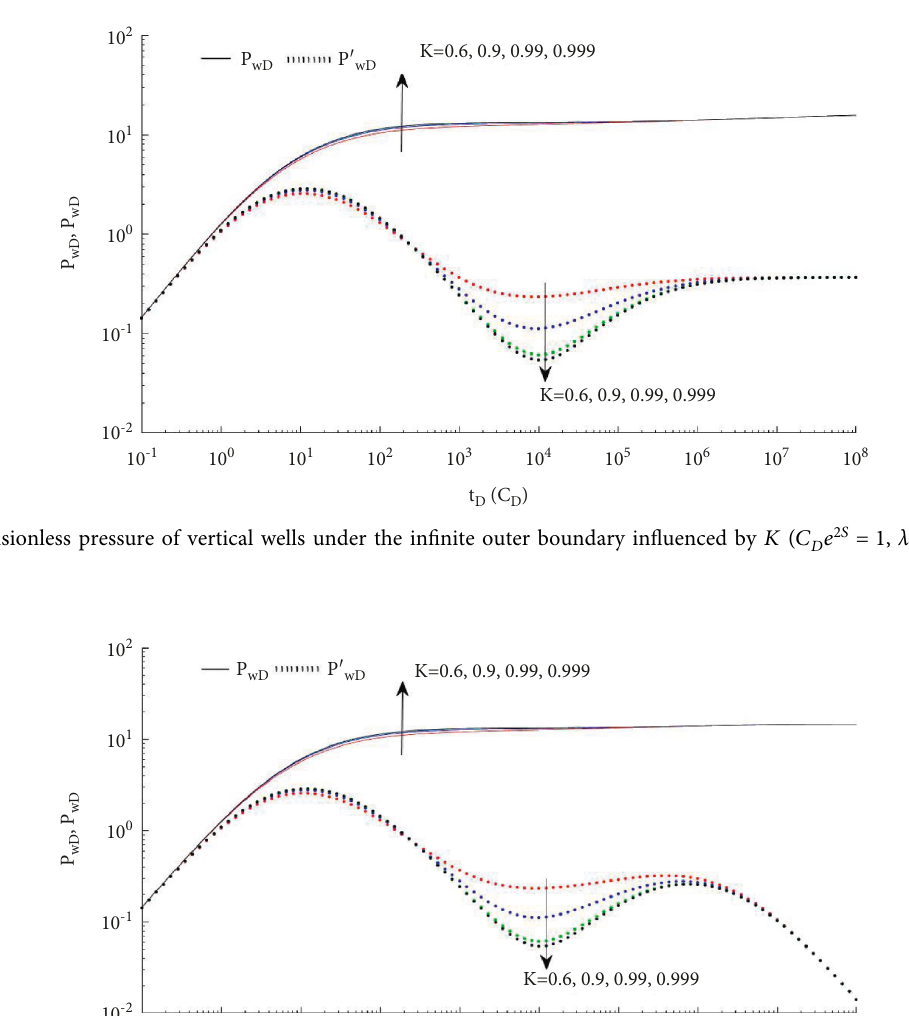
e 2 S � 1, λ � 10 − 5 , ω � 10 − 3 ). D